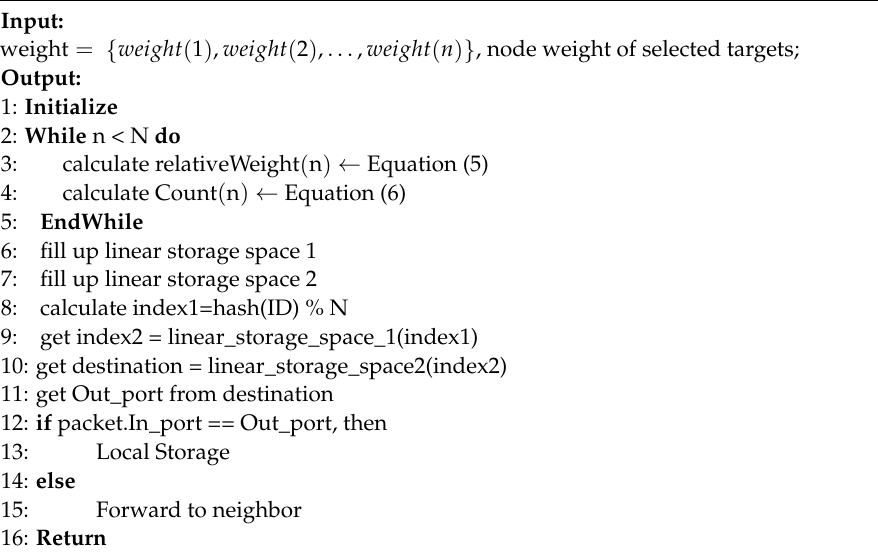
Algorithm 2 Cooperative storage algorithm.